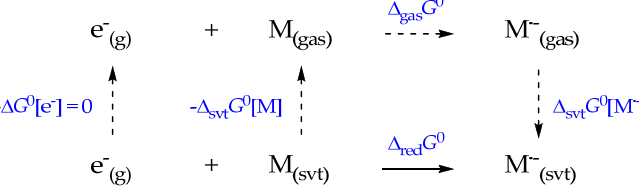
Scheme 1. Thermodynamic cycle used to describe the composition of Δ red G 0 and corresponding reduction potential. The solid arrow indicates the direct calculation, and dashed arrows indicate the indirect calculation path.